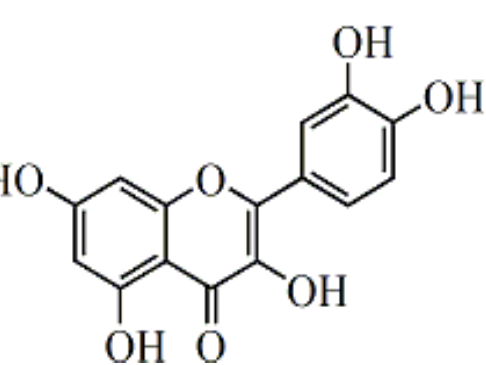
Figure 1. Structure of